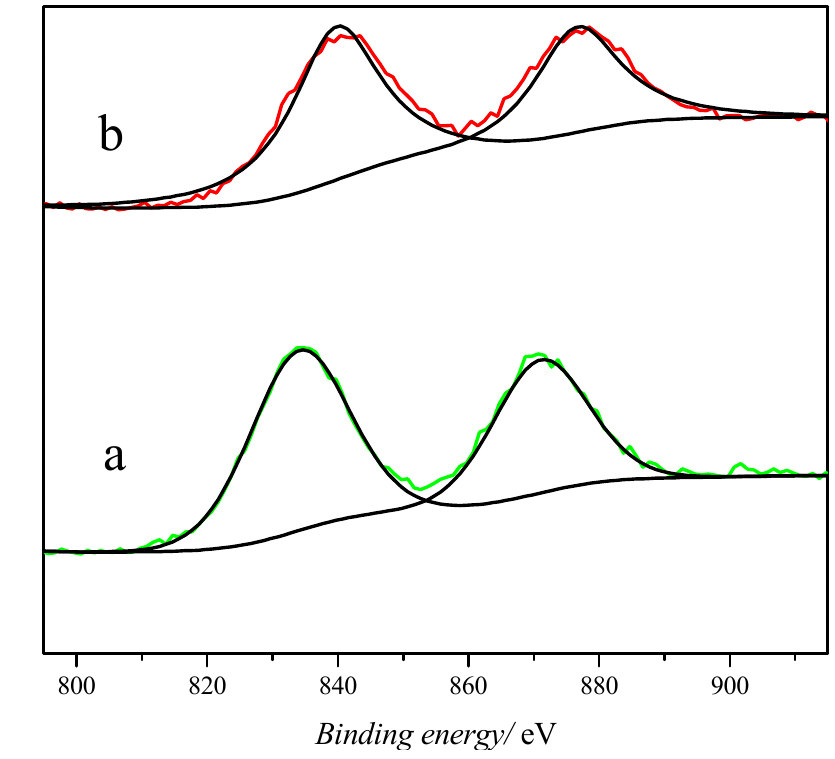
Figure 5. X ‐ ray Photoelectron Spectroscopy (XPS) spectra of the Au 4f binding energy region for ( a ) Au ‐ DDA/ γ‐ Al 2 O 3 ; and ( b ) Au ‐ DDA/ γ‐ Al 2 O 3 (O 3 8 h).